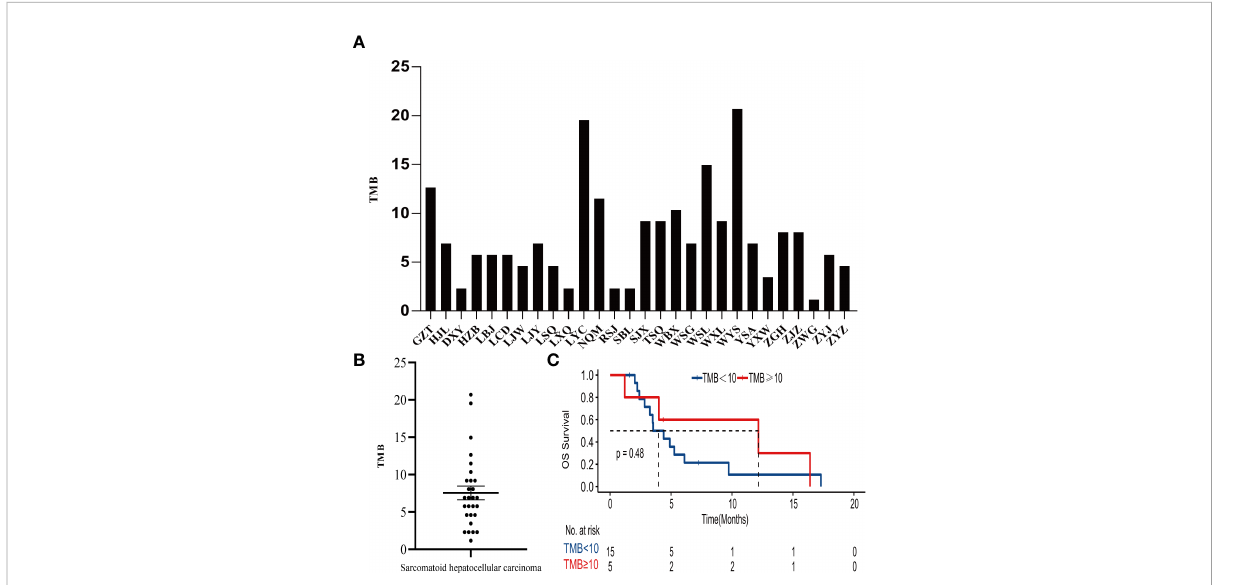
FIGURE 2 (A) Distribution of TMB in each patient, (B) the median number of TMB in the SHC patients, (C) Kaplan- Meier estimates of overall survival in SHC comparing patients with high TMB and low